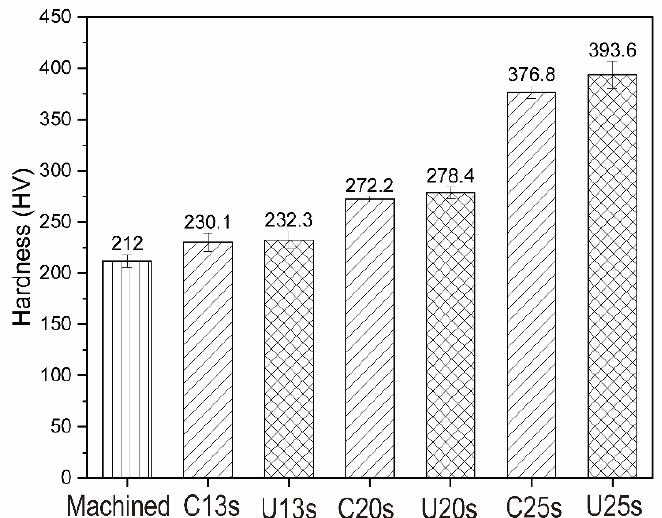
Figure 8. Micro-hardness of titanium surface (Machined) after IHT for 13 s (C13s), 20 s (C20s) and 25 s (C25s), ultrasonic-assisted IHT for 13 s (U13s), 20 s (U20s) and 25 s (U25s). The data is shown as mean ± SD, n = 5.